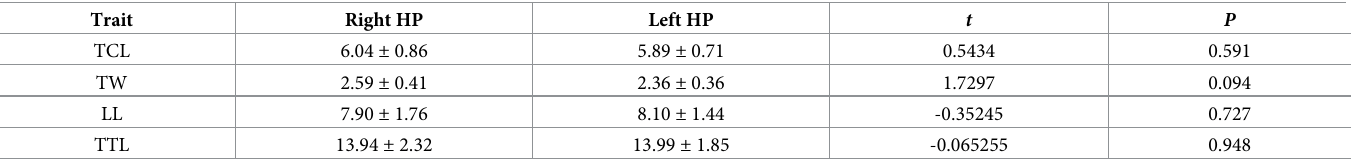
Mean and Standard Deviation of: truncus length (TCL); truncus width (TW); lobe length (LL), and total length (TTL) in right and left hemipenes. Asymmetry results ( t ) and significance ( P